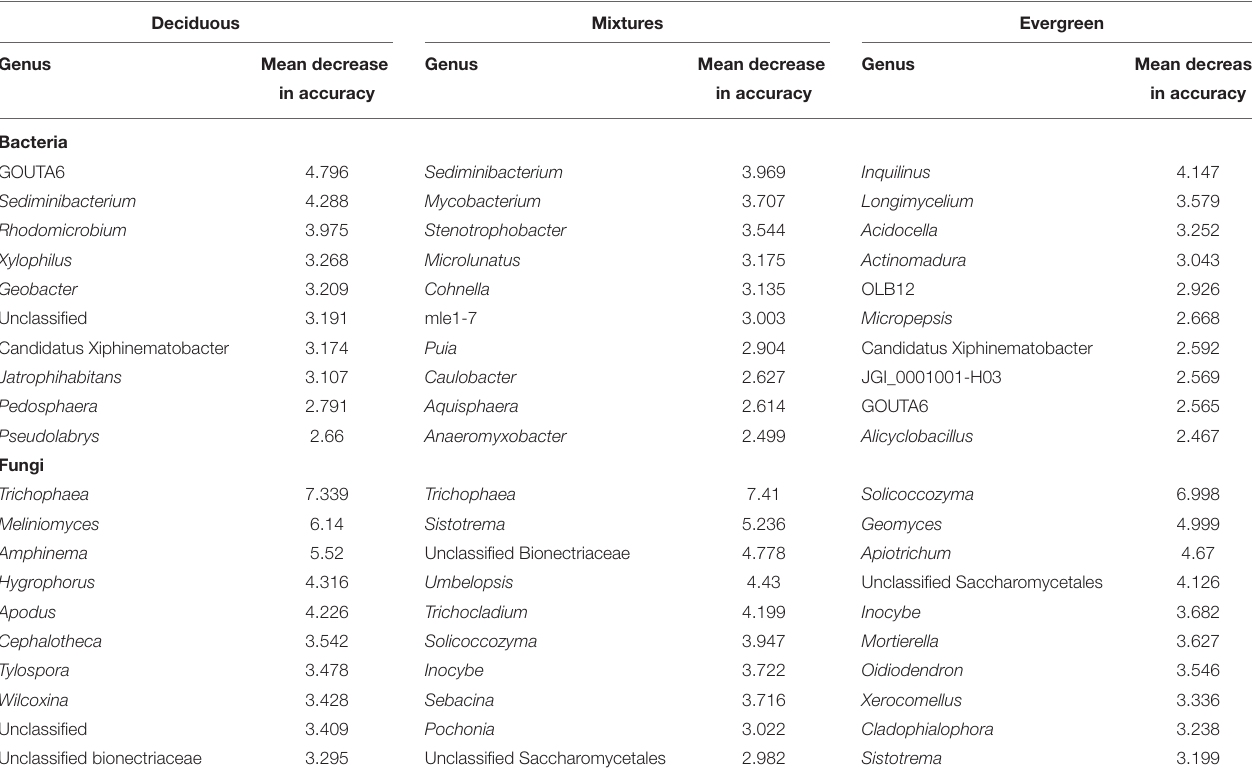
TABLE 1 | Top 10 bacterial and fungal genera associated with forest composition based on our RF model. Deciduous Mixtures